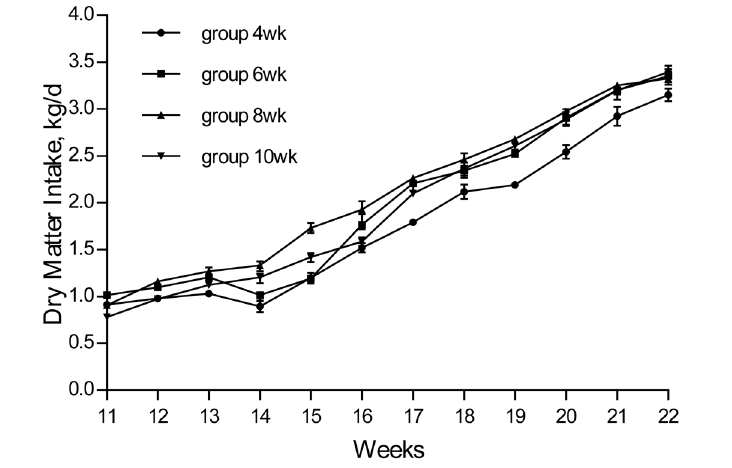
Figure 3. Effect of weaning age on dry matter intake from 11 wk to 22 wk was shown as means±standard errors. Control group not